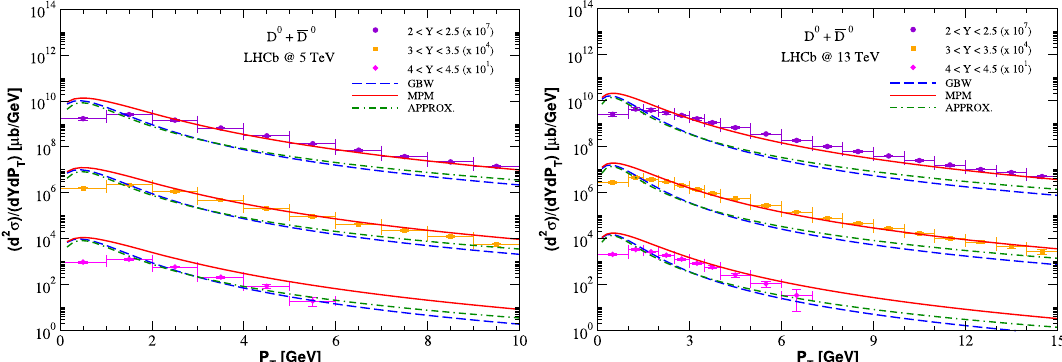
Fig. 1 The differential D 0 production cross section as a function of √ P T and Y in pp collisions at s = 5 and 13 TeV considering forward rapidity bins. The results with the GBW, MPM and APPROX. models